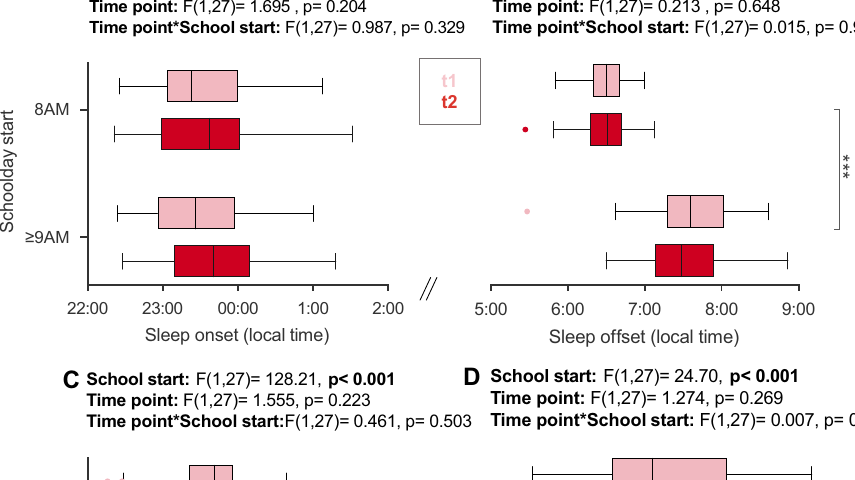
(Fig. 2C,F, full statistics in Figures). Findings from cohort 2 (n = 79) tally with this pattern: sleep onsets on 8AM and ≥ 9AM-days were comparable (t[78] = − 1.87, p = 0.065; d z = 0.210), while wake up times were significantly later on ≥ 9AM-days (t[78] = − 19.75, p < 0.001, d z = 2.222), which resulted in 60 min longer sleep durations on those days (t[78] = − 10.83, p < 0.001, d z = − 1.218). This large sleep gain likely results from ≥ 9AM-days incorpo- rating not only 8:50-starts (75%) but also some 10:15-starts (25%). Furthermore, subjective sleep quality was improved on ≥ 9AM-days by 1 point on a 10-point Likert scale for cohort 1 47 and cohort 2 (n = 79, Z = − 5.874, p < 0.001, d = − 1.761), and also longitudinally across time points (n = 28, Fig. 2D). In addition, the extensive use of alarm clocks remained slightly reduced on ≥ 9AM-days also 1 year into the system (Fig. 2E). Just as in cohort 1 47 , the odds for less alarm-driven waking were increased in